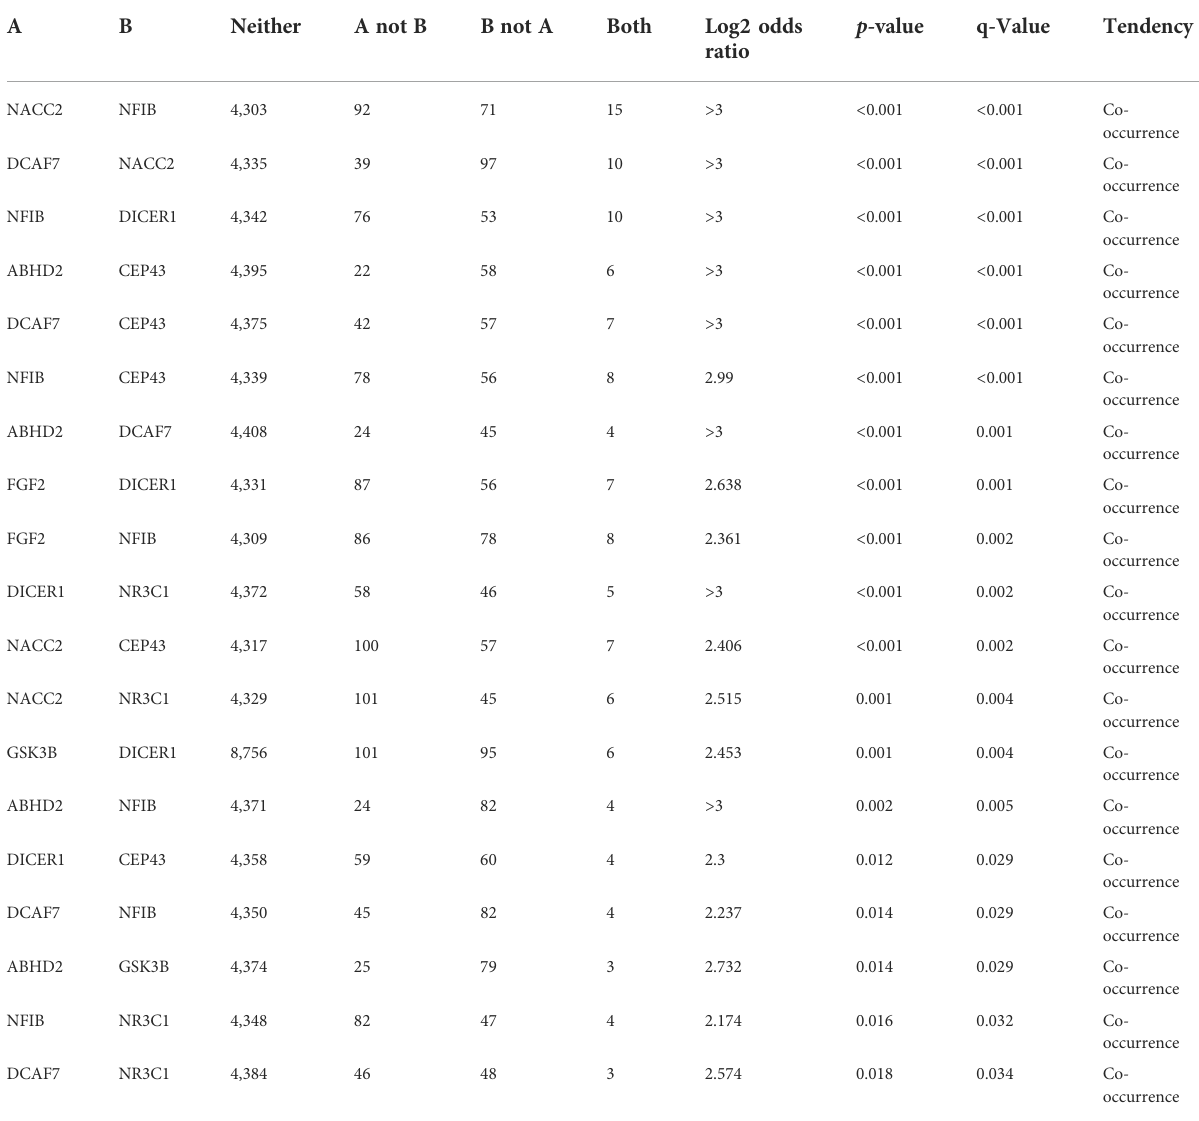
TABLE 6 Co-occurrence analysis of hub genes of prostate